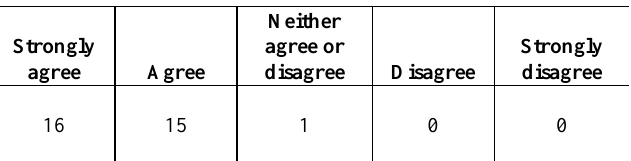
Table 1: Does this organisation encourage employees